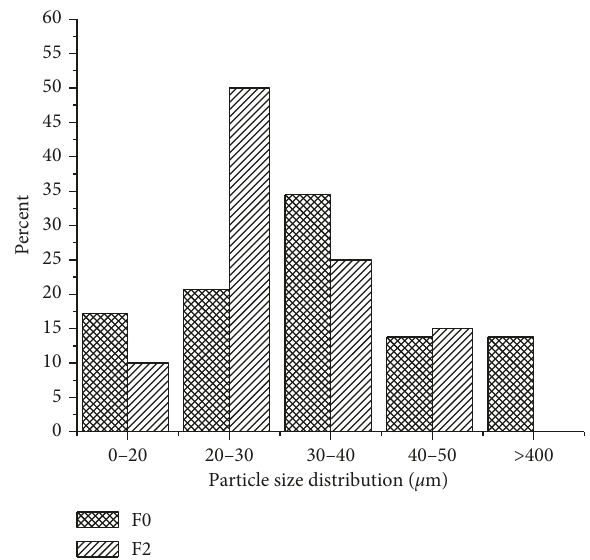
Figure 3: The particle size distribution of the cenospheres before and after